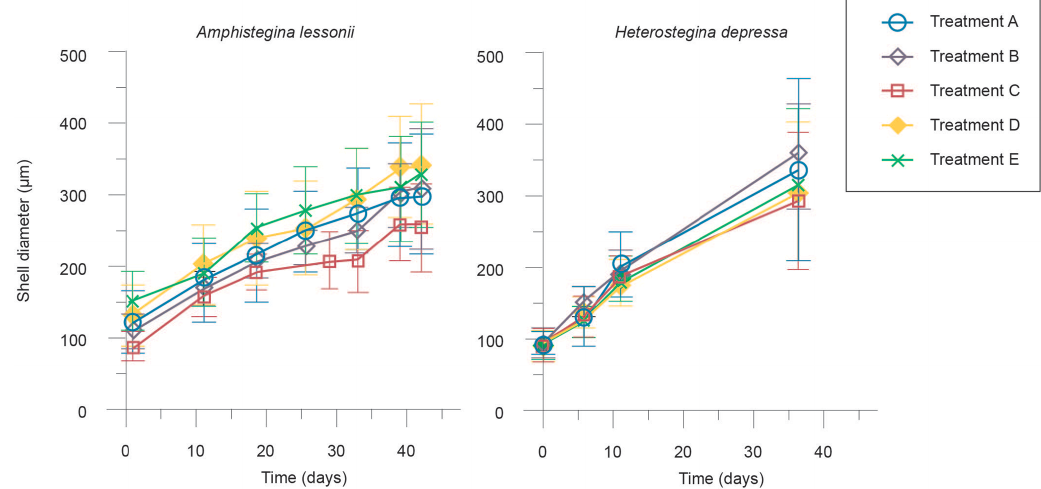
Figure 1. Average increase in shell diameter for A. lessonii (left panel) and H. depressa (right panel). Dots represent the average of all analyzed individuals from one treatment. Error bars represent the standard deviation of the mean.